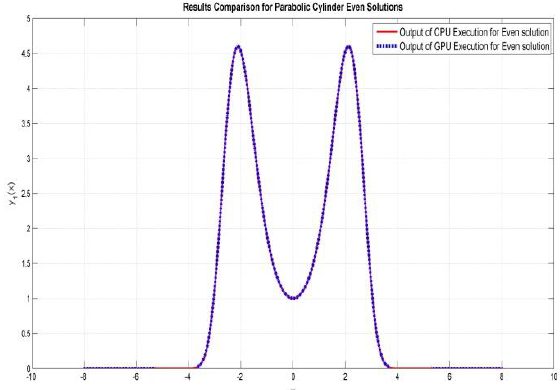
Fig. 4. Output Benchmarking plots of Even Parabolic Cylinder